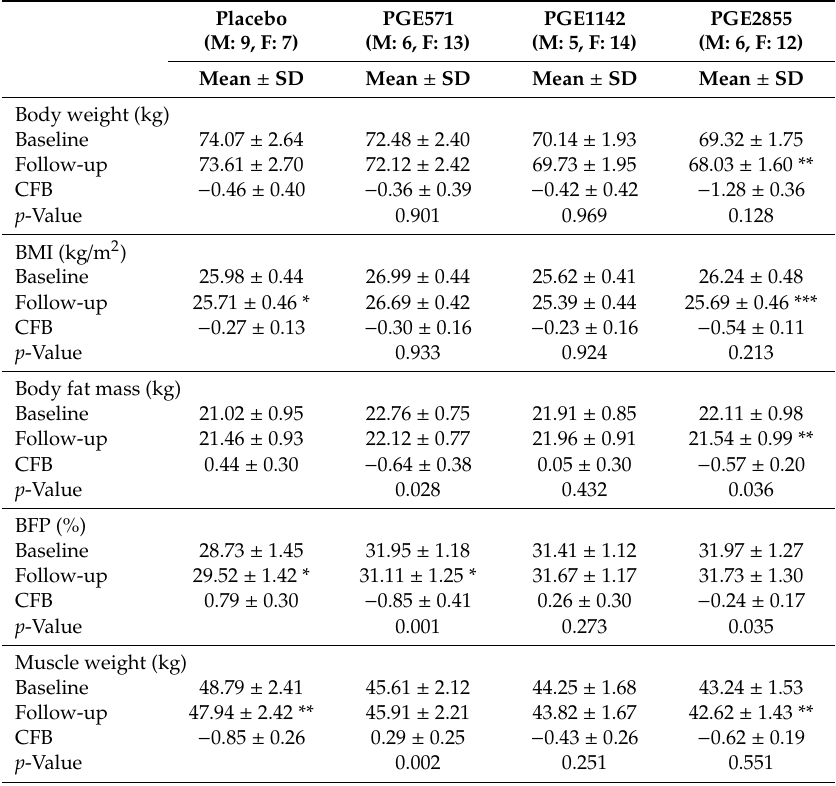
Table 4. E ff ect of PGE supplementation for 12 weeks on change of body composition measured by bioelectrical impedance analysis (BIA), WHR-related body measurements, and blood pressure in groups with overweight or obesity.